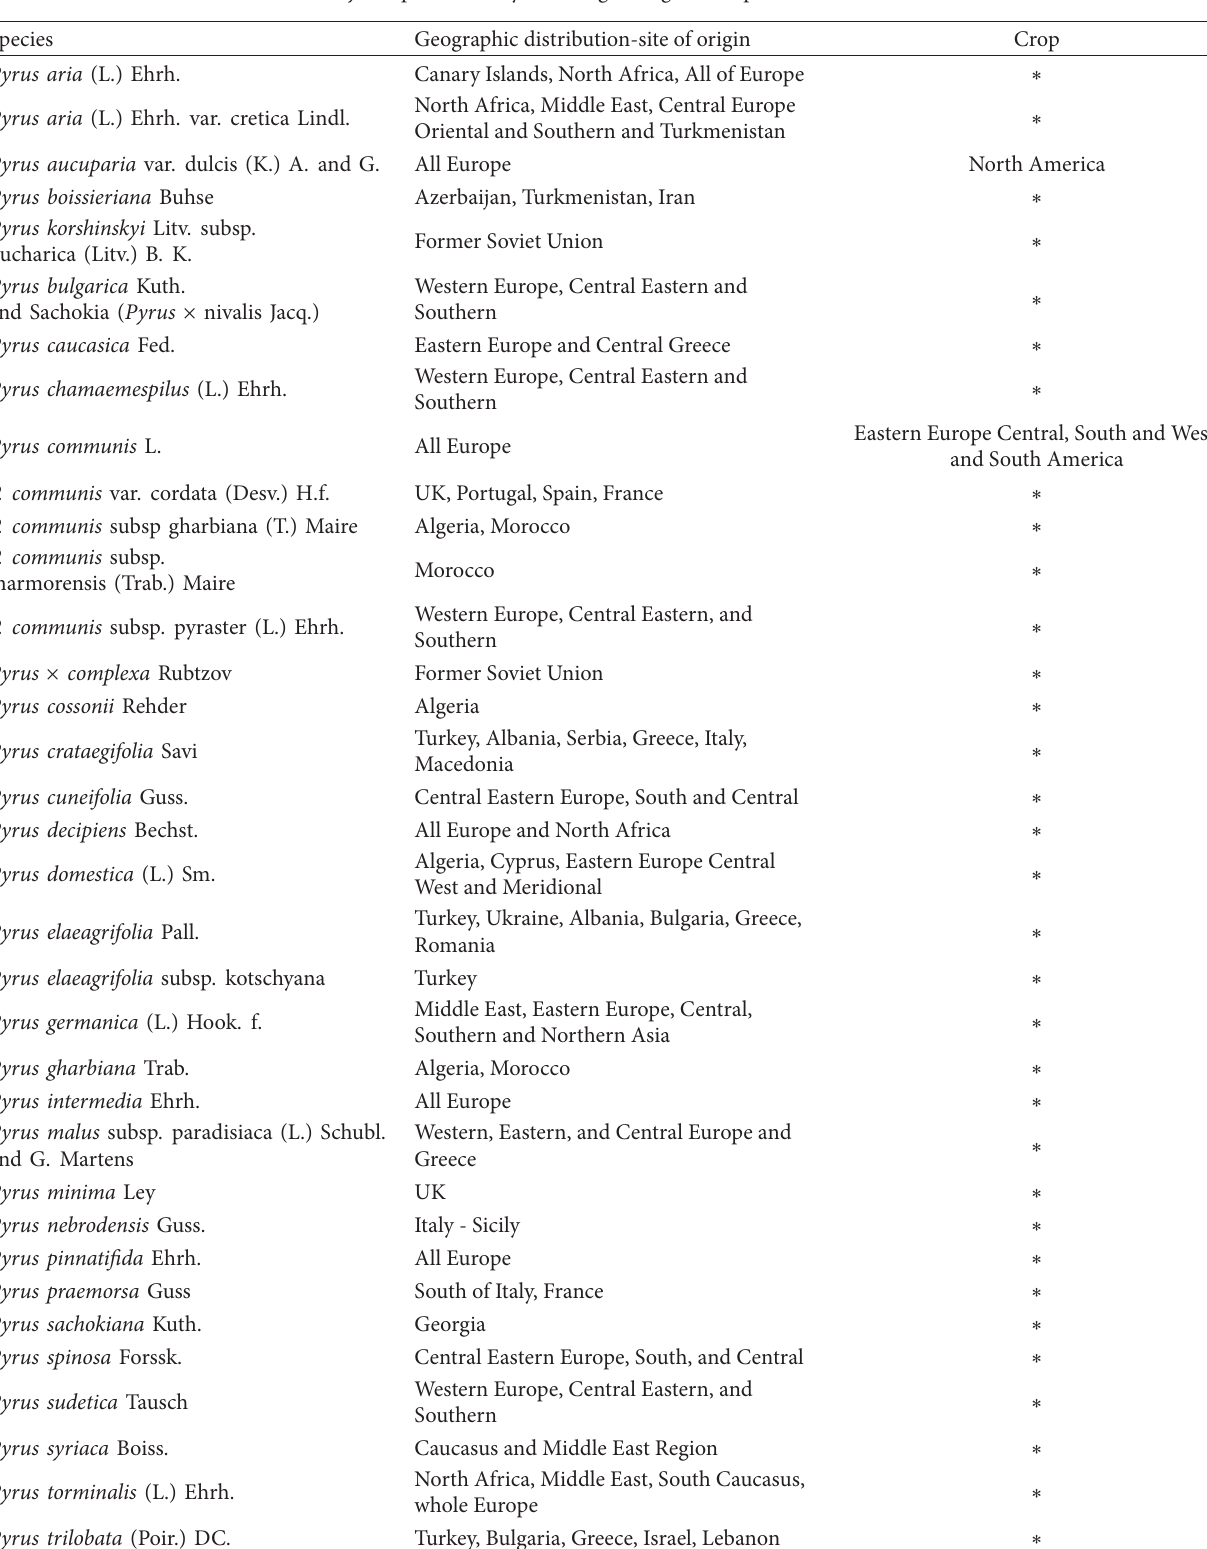
Table 2: Pyrus species and hybrids originating in Europe and Southern